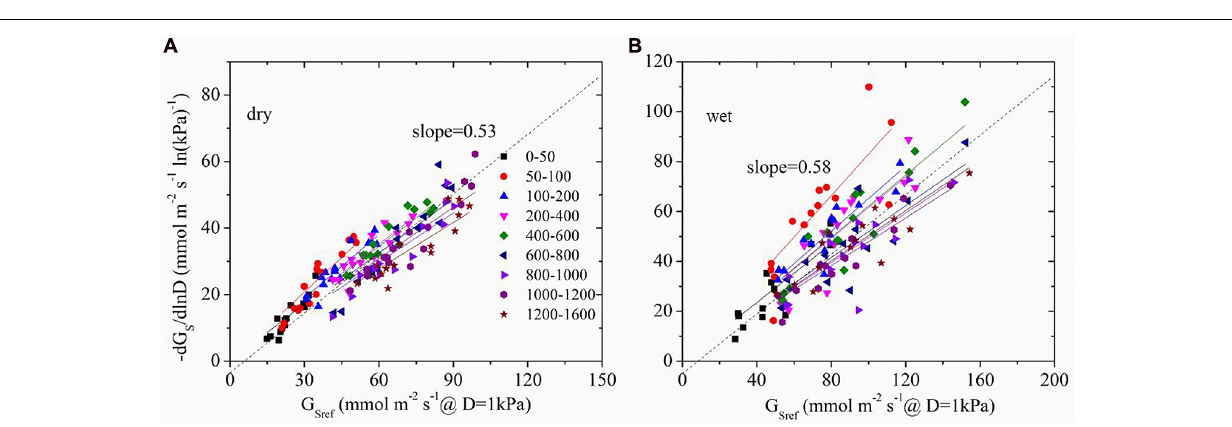
FIGURE 4 | The sensitivity of average stomatal conductance of tree individuals at each light level in response to increasing vapor pressure deficit ( − dG s /dlnD) as a function of the canopy stomatal conductance at D = 1 kPa (G Sref ) in dry (A, October) and wet season (B, April). Different symbols represent the different light